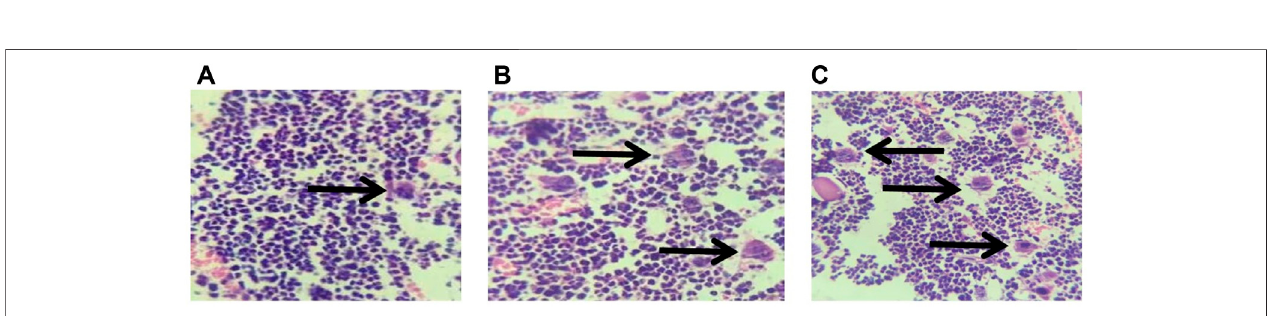
FIGURE 2 | pathological sections of mouse bone marrow tissues (HE staining, 40 x ). (A) :Control (0 mg/ml) (40 × ). (B) :Low-dose group (0.1 mg/ml) (40 × ). (C) : High-dose group (0.2 mg/ml) (40 × ).